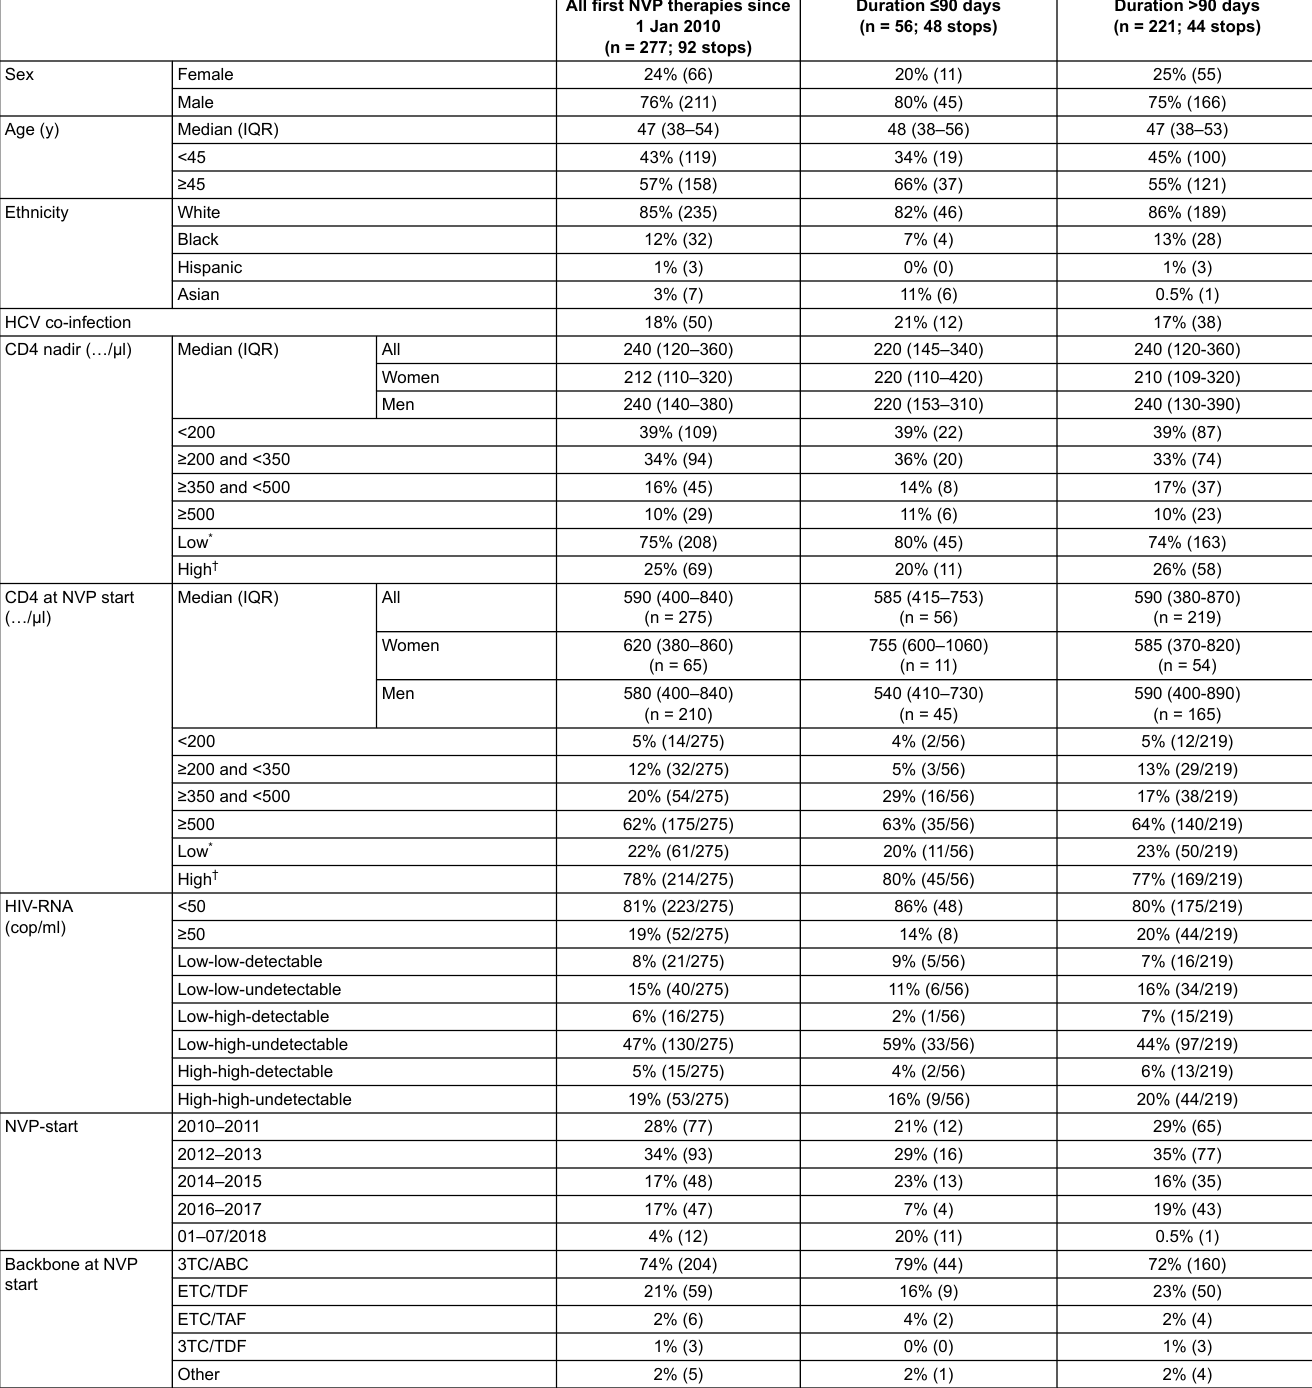
Table 1: Baseline characteristics of patients using